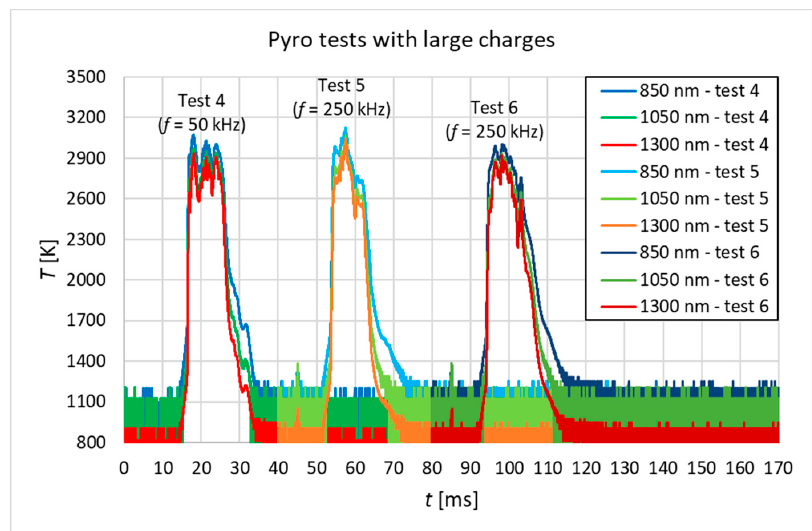
Figure 11. Time trend of temperatures for pyrotechnic tests with large charges—temporal offset introduced for clarity.